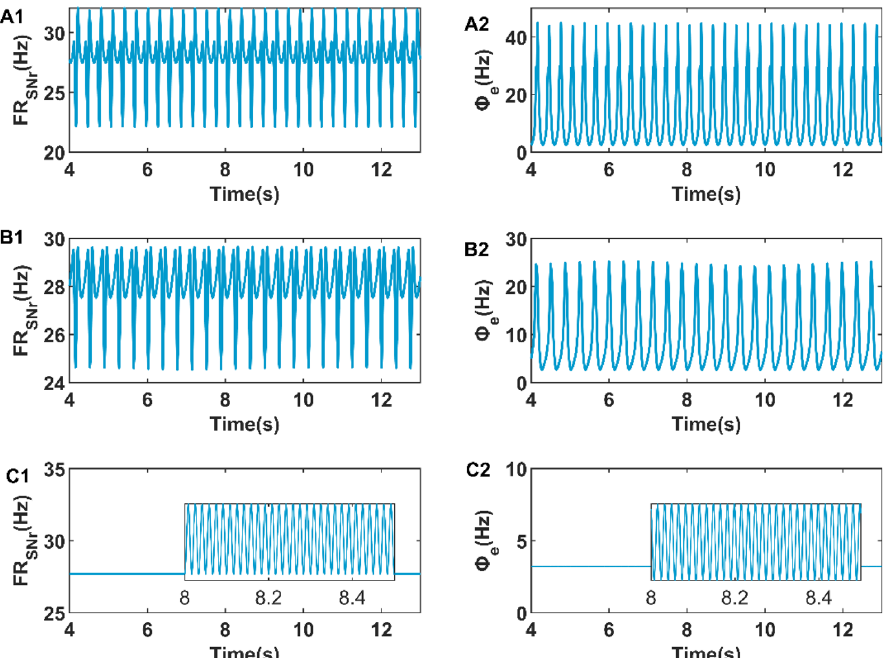
Figure 7. The firing rate of SNr when the frequency of DBS stimulation is 20 Hz ( A1 ), 40 Hz ( B1 ), and 60 Hz ( C1 ). The firing activity of cerebral cortex when the frequency of DBS stimulation is 20 Hz ( A2 ), 40 Hz ( B2 ), and 60 Hz ( C2 ).